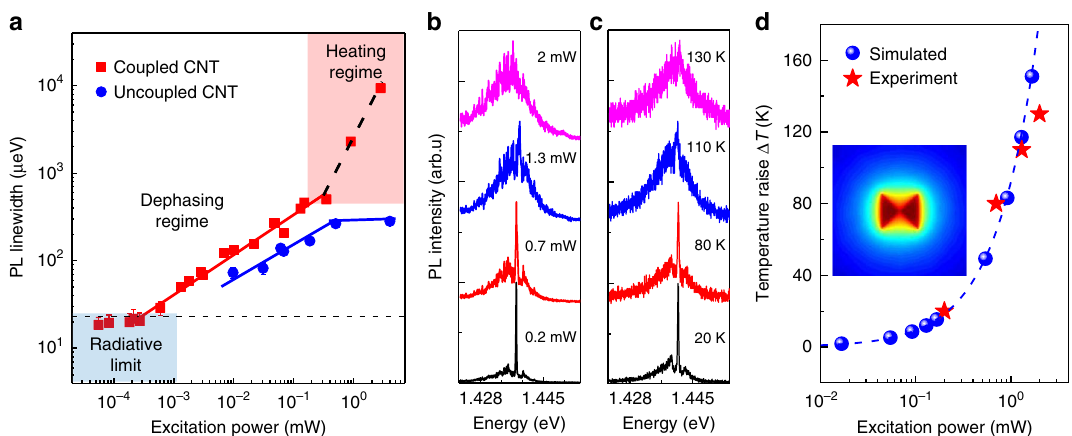
Fig. 5 Excitation power and temperature dependence of the E 11 exciton emission linewidth. a Spectral linewidth determined from Voigt deconvolution fi ts (Supplementarty Note 7) as a function of laser excitation power (780 nm) for a plasmonically coupled SWCNT (red squares) and reference SWCNT (blue circles). The blue box highlights the pump regime when the linewidths reaches the Purcell-enhanced radiative lifetime limit of the emitter ( T 1 = 37 ps = 18 µ eV). Gray dashed line illustrates spectral resolution limit (23 µ eV). The red box highlights the pump regime where plasmonic heating affects the emission spectrum. Data are recorded at 3.8 K. b PL spectra for the coupled SWCNT recorded in the plasmonic heating regime where a signi fi cant lattice temperature increase causes the break-up of the acoutic-phonon con fi nement leading to strong linewidth broadening. c Comparision spectra for the coupled SWCNT recorded under moderate pump powers of 200 μ W and for increasing temperature from 20 to 130 K. d FDTD simuation of temperature raise Δ T of the bowtie structure as a function of excitation power (blue dots). Inset: Simulated heat map of the bowtie antenna. The red stars are the data points from the experiements in b with the temperature equivalent taken from the experiment in